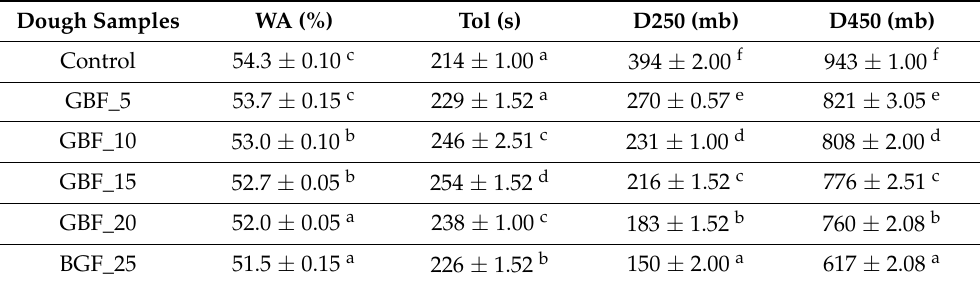
Table 1. Consistograph parameters of the dough samples with different levels of germinated bean flour (BGF)